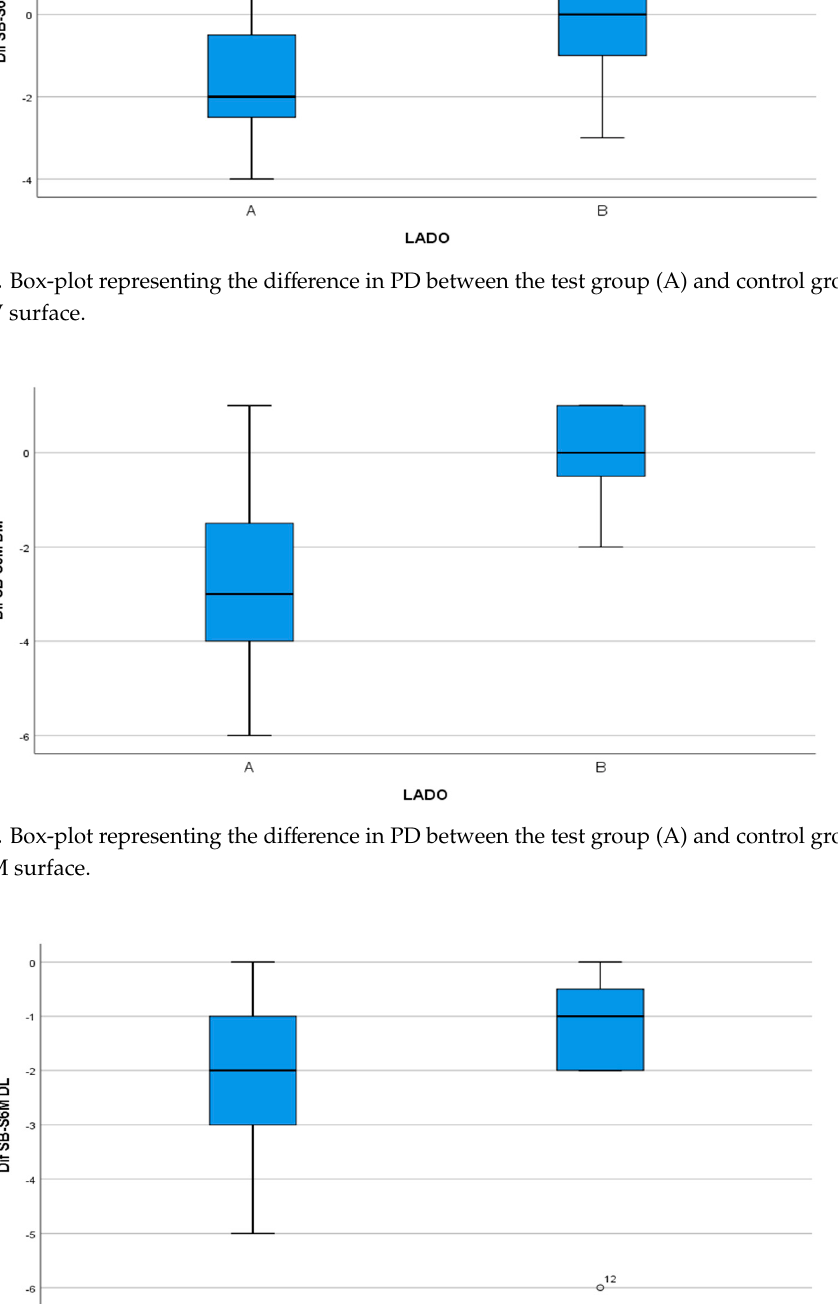
Figure 12. Box-plot representing the di ff erence in PD between the test group (A) and control group (B) Figure 12. Box-plot representing the difference in PD between the test group (A) and control group on the DL (B) on the DL surface. Figure 12. Box-plot representing the difference in PD between the test group (A) and control group (B) on the DL surface. Figure 12. Box-plot representing the difference in PD between the test group (A) and control group (B) on the DL surface.